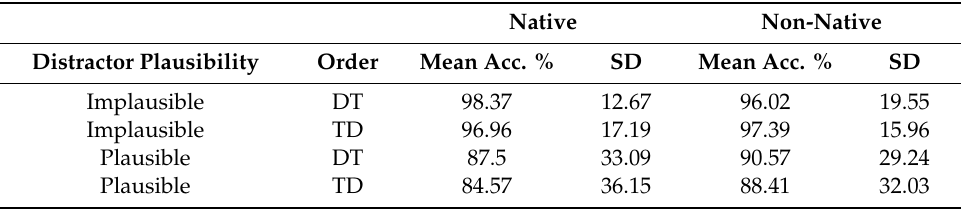
Table 4. Results of accuracy in selection of the target verb by